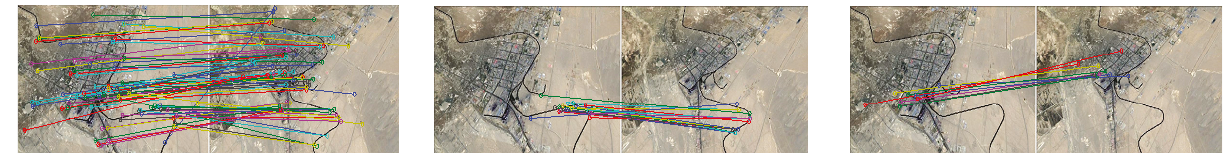
Figure 20: Qingzang railway registration result with SURF, PCA-SURF, and CSA-SURF.